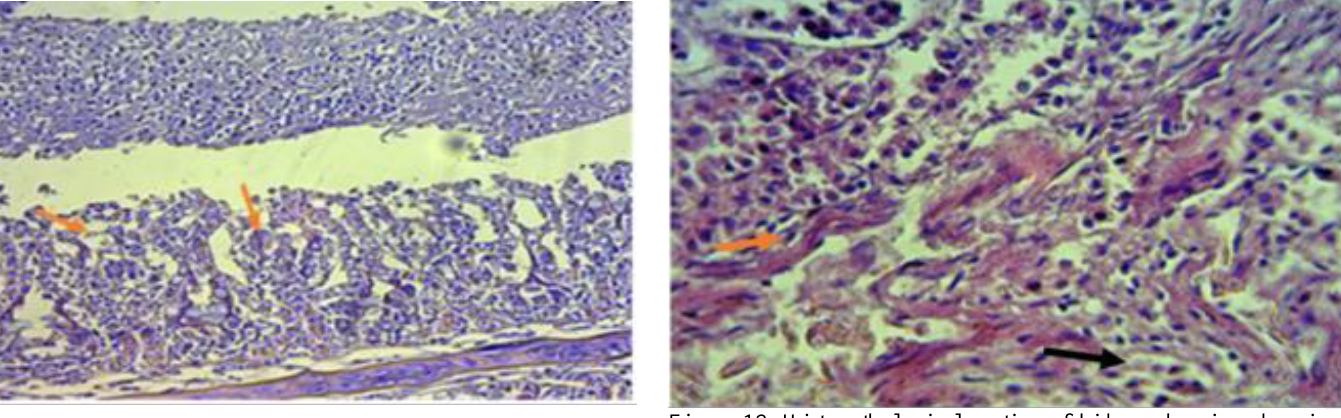
Figure 9. Histopathological section of gills shows necrosis of the gills filaments with inflammatory cells infiltration (